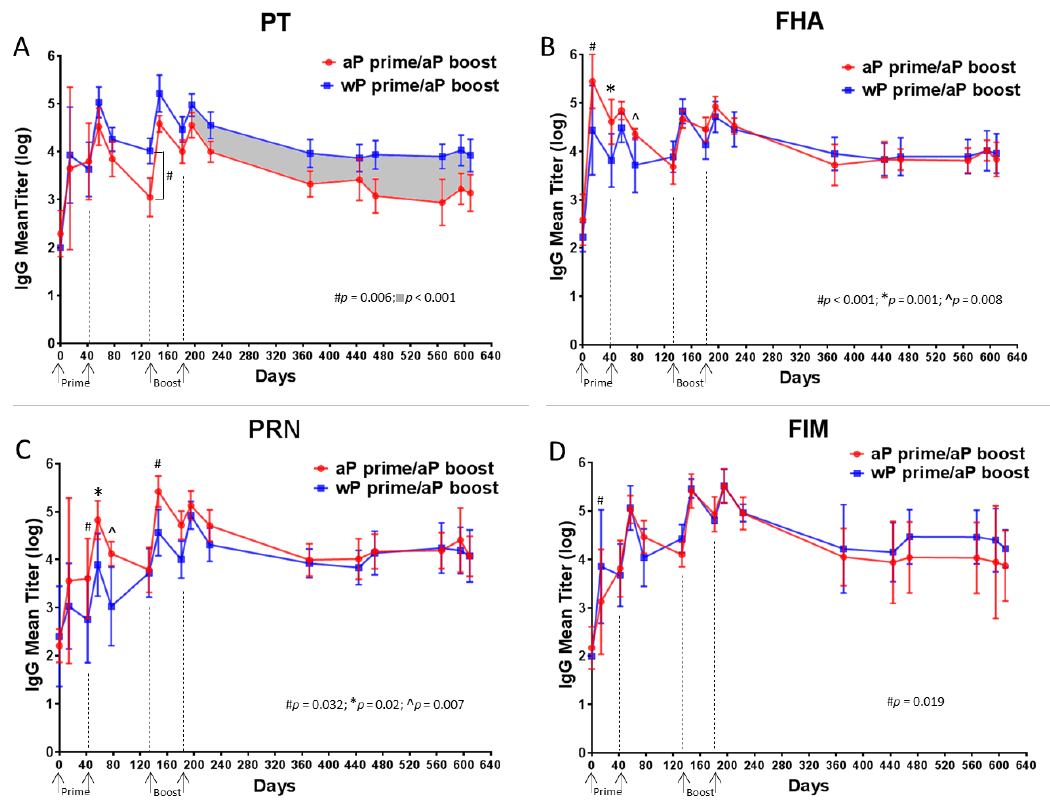
Figure 5. Analysis of PT- ( A ), FHA- ( B ), PRN- ( C ), Fim 2/3 ( D )-specific IgG antibodies revealed differences in durability and magnitude of response. The data shown in the graphs at each time point are the means of 6 individual values with 95% CI noted with the corresponding lines. A statistical analysis was performed using two different models: (i) ANOVA model with the specific primary vaccine immunization (aP or wP) as the fixed factor for each time point D14, D42, D57, D77, D133, D147, D181, D196. (ii) ANCOVA model with group as the fixed factor and time as the covariate from D196 to D609. The p values are listed on the specific graphs.